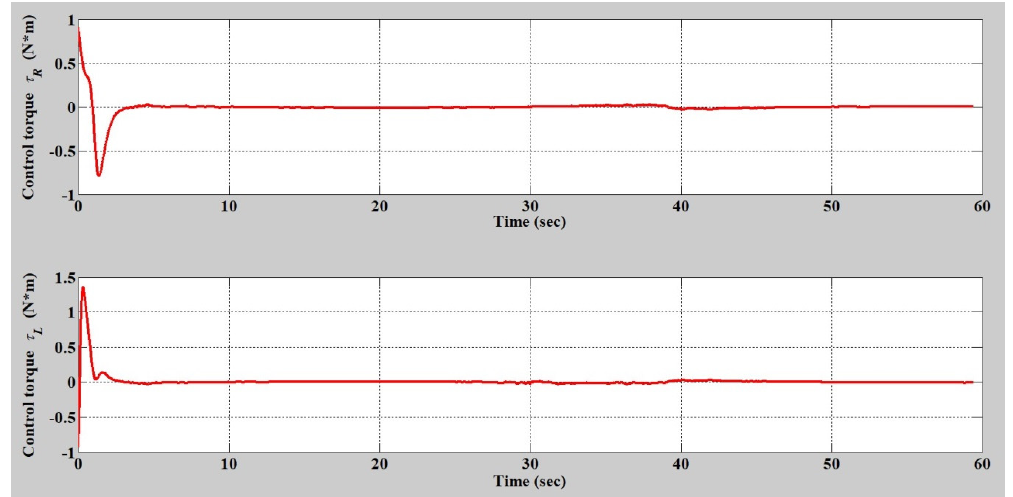
Figure 16. Results of S-type trajectory tracking torques concerning initial point ( x c = 1.9 m, y c = 0 m). Appl. Sci. 2019 , 9 , x FOR PEER REVIEW